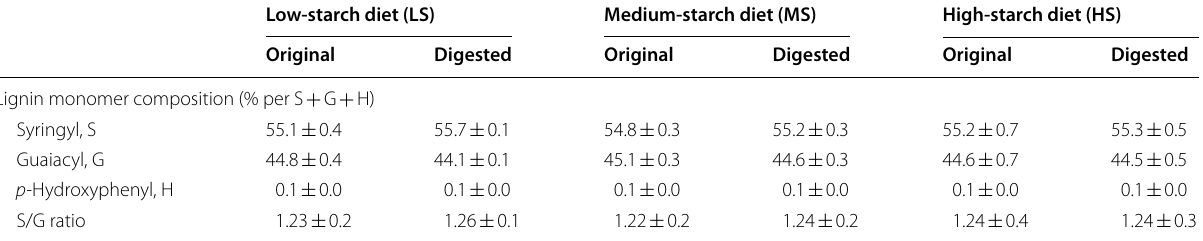
Table 3 Thioacidolysis-based lignin compositional analysis of original artificial diets and fecal residues of N. hirtum larvae